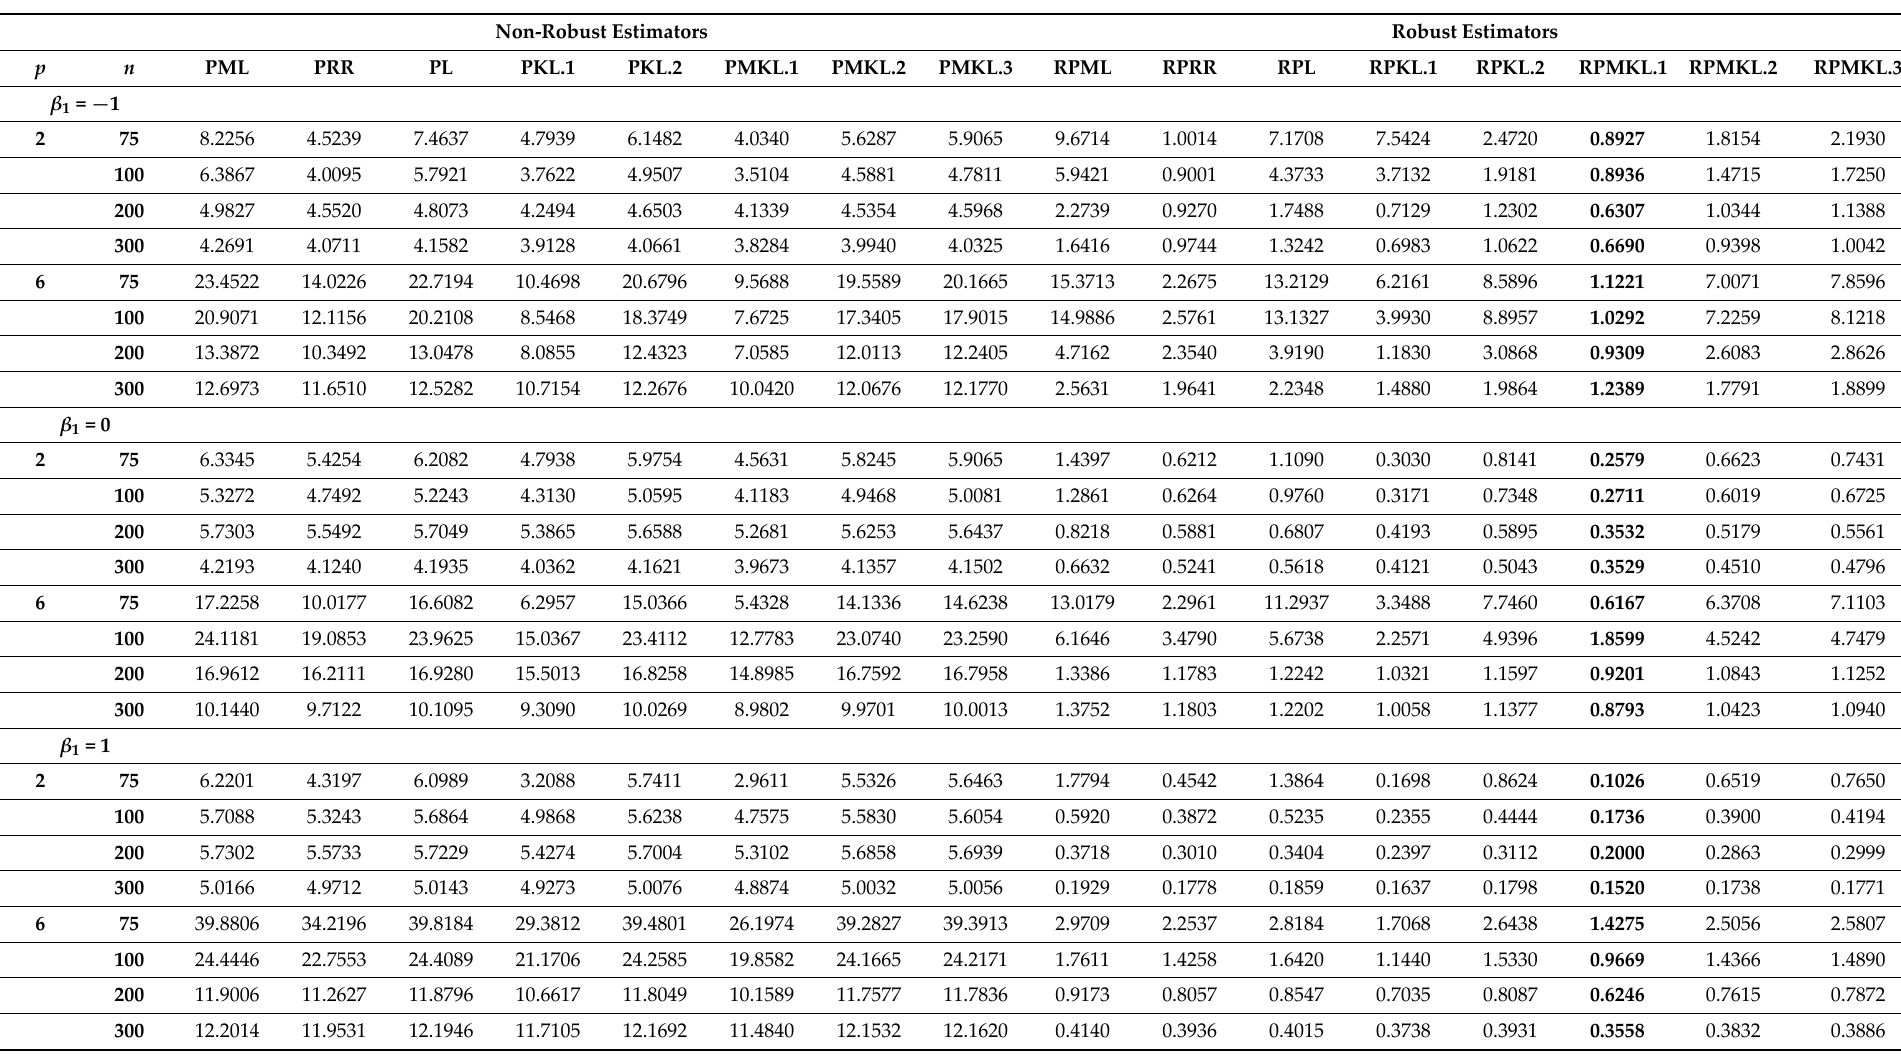
Table A9. AMSE of different estimators when τ = 20% and ρ =